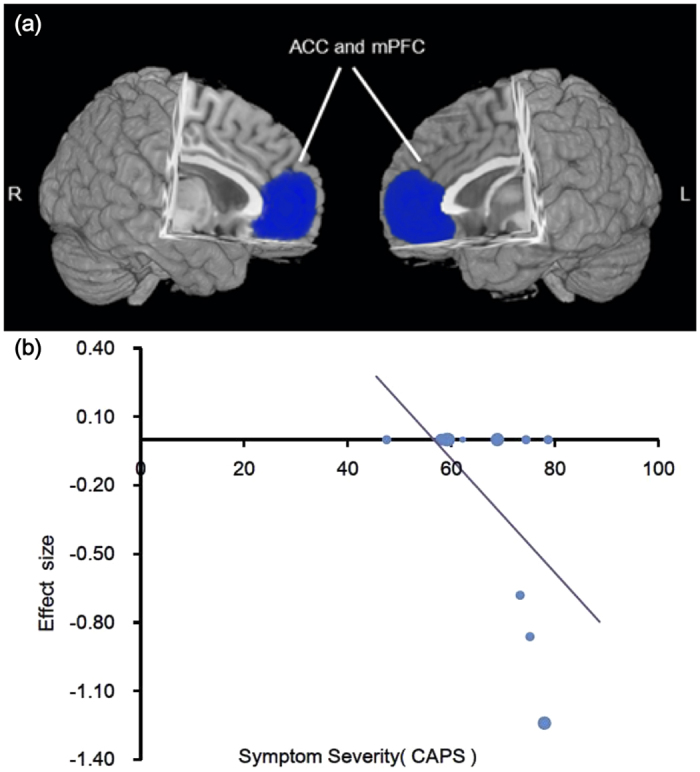
Association between CAPS and GM alterations in PTSD.(a) The brain areas associating with CAPS scores in PTSD patients; (b) relationship between CAPS scores and GM alterations of regions in a. The effect sizes were extracted from the peak of maximum slope significance. Each study is represented by a dot. The dot size reflects the sample size. Large dots are for studies with more than 20 patients; medium dots: 10–20 patients; and small dots: <10 patients. The blue areas depict significant GMRs by AES-SDM in PTSD compared with TEC. Abbreviations: mPFC, medial prefrontal cortex; ACC, anterior cingulate cortex; CAPS, Clinician-Administered PTSD Scale; L, left; R, right.